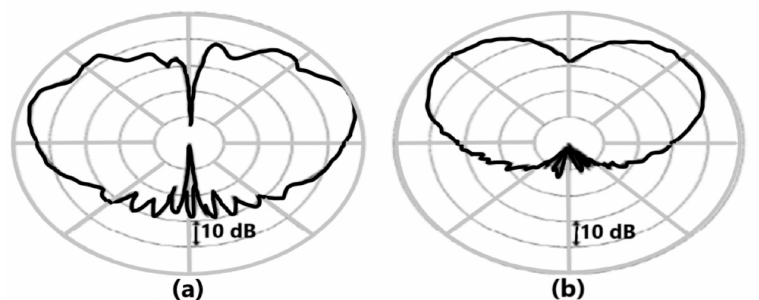
Figure 4. Measured radiation pattern of a vertical monopole antenna: ( a ) above PEC ground plane (PEC), and ( b ) above EBG ground plane, adapted from [51].